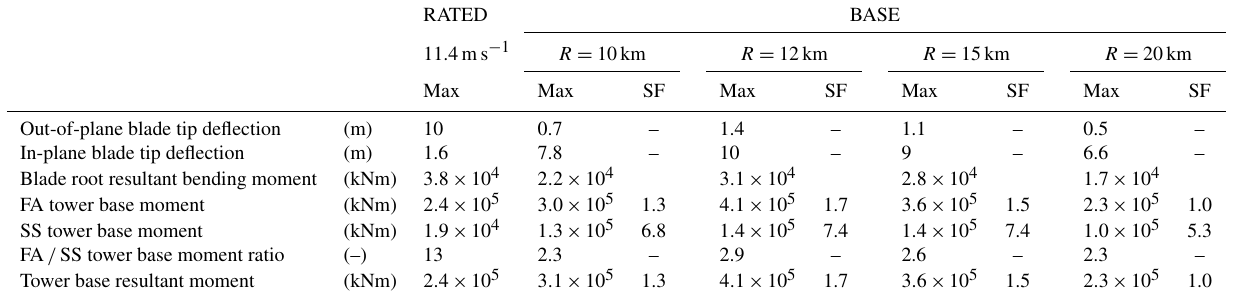
Table 4. Maxima of blade and tower structural response to the BASE hurricane wind case. The scale factor (SF) indicates the magnitude of response relative to RATED. Numerical values of the scale factors are not provided when not appropriate (for blade deflections the blade is oriented differently in RATED, and the scaling of FA–SS tower base moment ratios is not a meaningful measure of response).